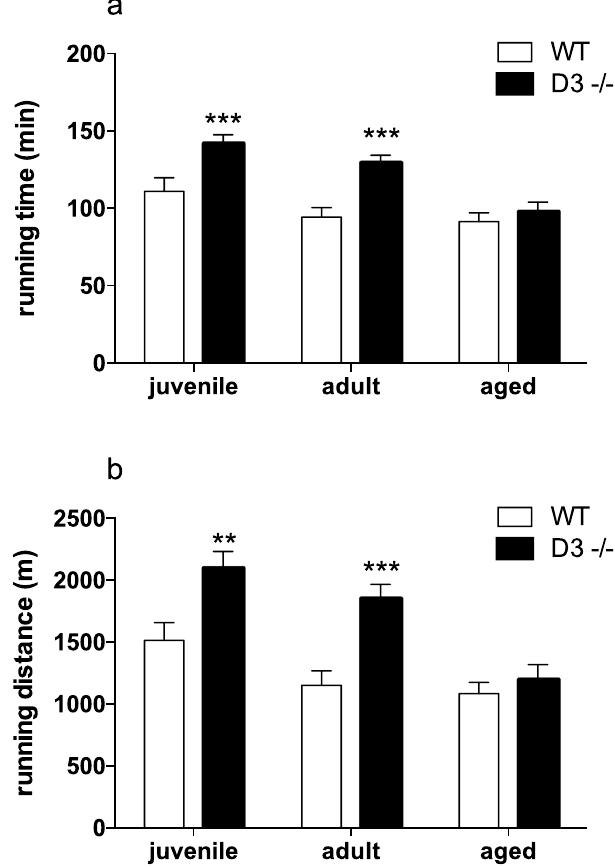
Figure 3. Lack of cyclin D3 improves exercise endurance. Running time (panel a) and running distance (panel b) were acquired in juvenile (D3 − / − , n = 13; WT, n = 12), adult (D3 − / − , n = 14; WT, n = 12), and aged mice (D3 − / − , n = 11; WT, n = 10) during a treadmill endurance exercise as described in methods. Data are reported as means + / − SEM and statistical difference between WT and D3 − / − mice were calculated by two- way ANCOVA, using body weight as a covariate, followed by Fisher PLSD post-hoc comparison of age matched D3 − / − vs. WT mice. Compared to WT mice, both running time and running distance were significantly increased in D3 − / − juvenile ( ** p < 0.01) and D3 − / − adult ( *** p < 0.001), but not in D3 − / − aged